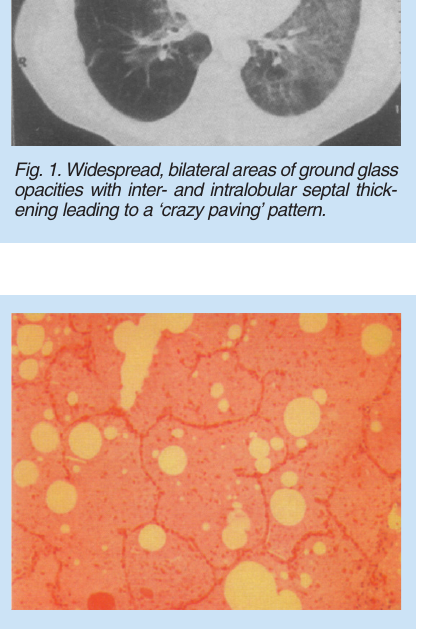
Fig. 2. Alveoli filled with an eosinophilic, granular material, staining with periodic acid Schiff (PAS). Note the preservation of the alveolar